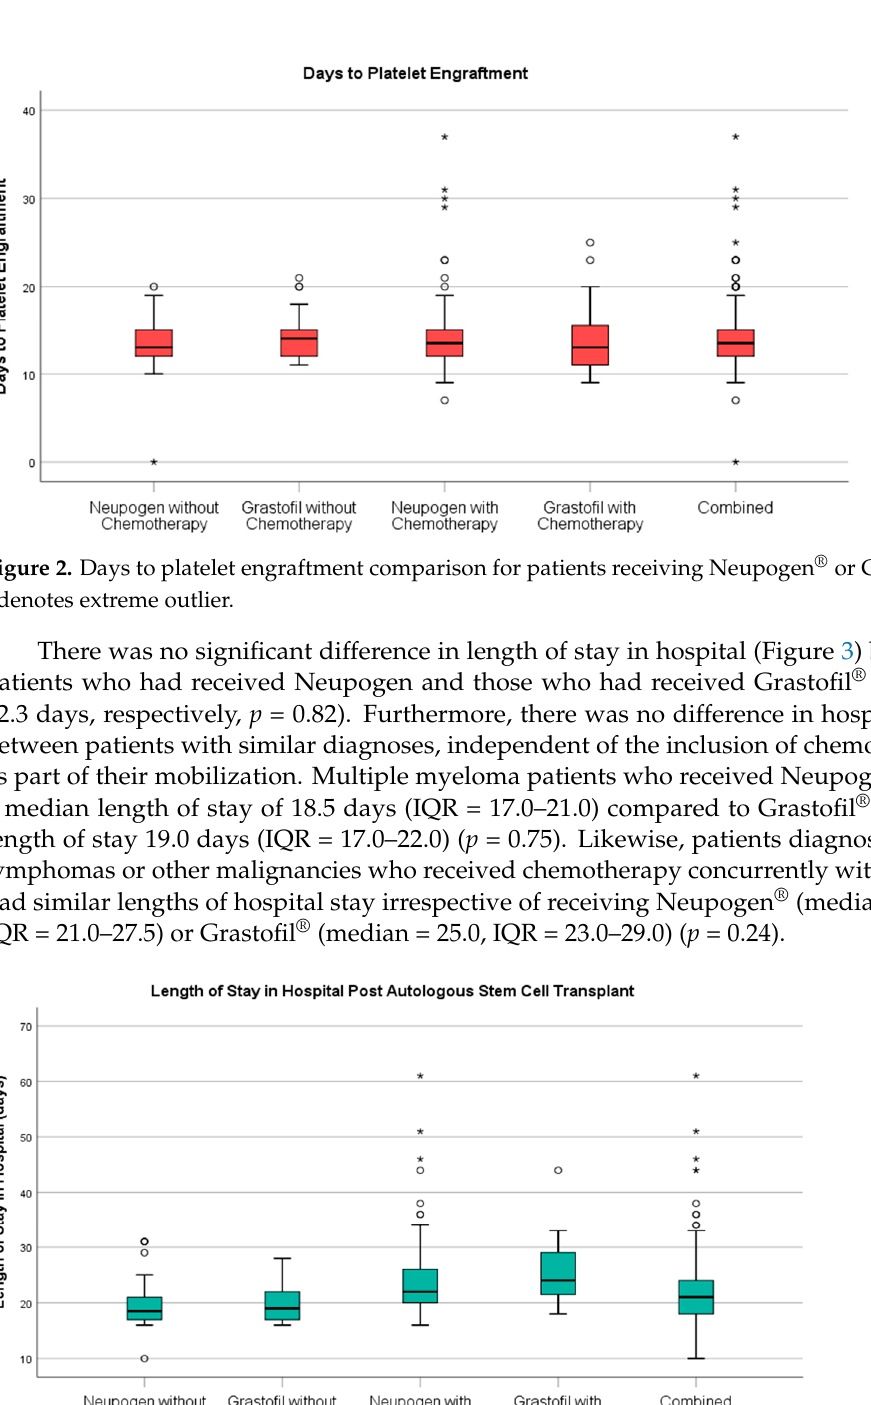
Figure 1. Days to ANC engraftment comparison for patients receiving Neupogen ® or Grastofil ® . * denotes extreme outlier.